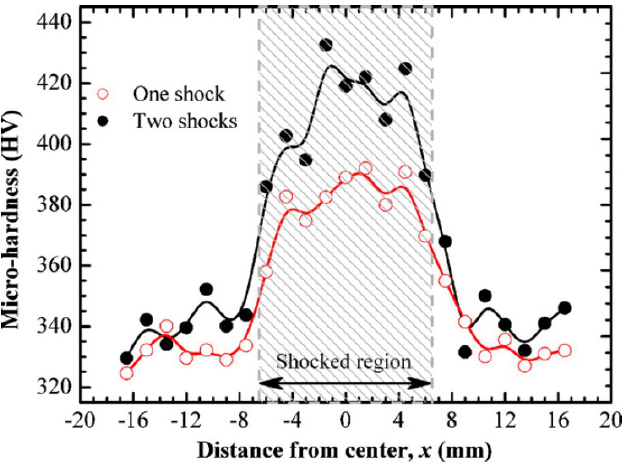
Figure 14. Microhardness at the surfaces of Ti-6Al-4V specimens shocked with three 40% overlapped spots [53].